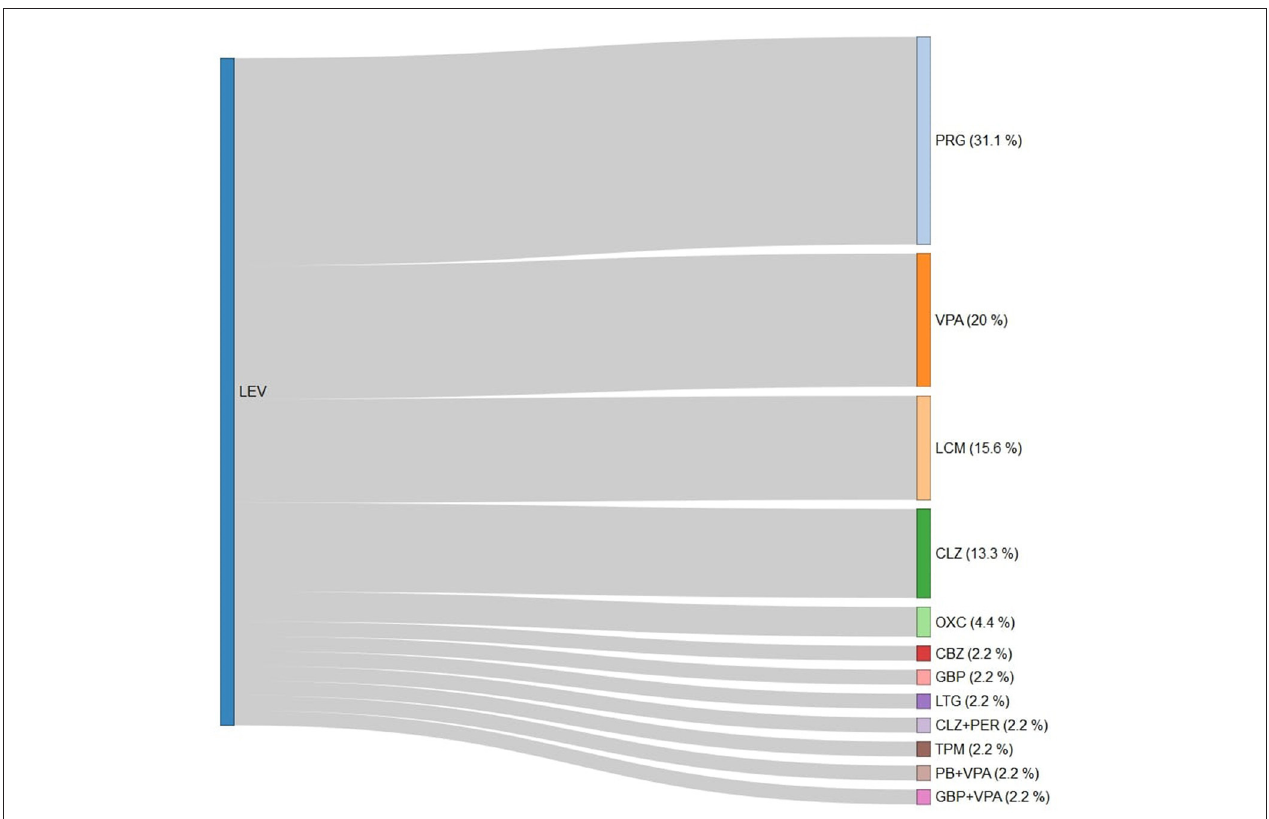
FIGURE 2 | Antiseizure medication switch from levetiracetam in the study cohort. LEV, levetiracetam; PRG, pregabalin; VPA, valproate; LCM, lacosamide; CLZ, clonazepam; OXC, oxcarbazepine; CBZ, carbamazepine; GBP, gabapentin; LTG, lamotrigine; PER, perampanel; TPM, topiramate; and PB, phenobarbital.